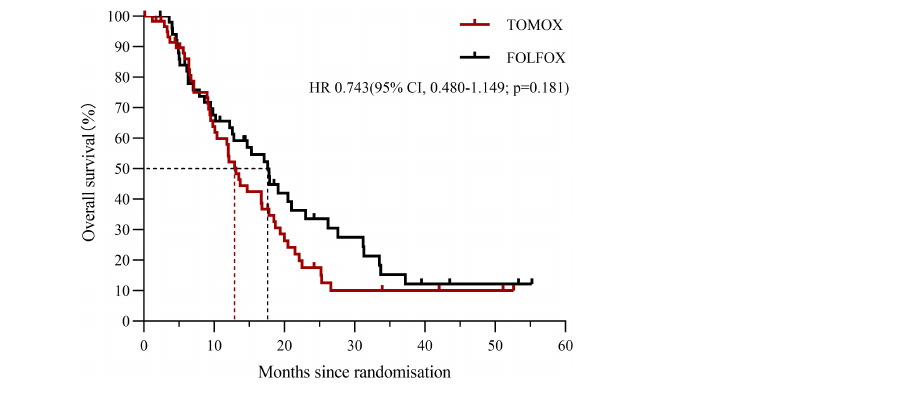
FIGURE 2 OS since randomization for patients receiving HAI of FOLFOX or TOMOX.